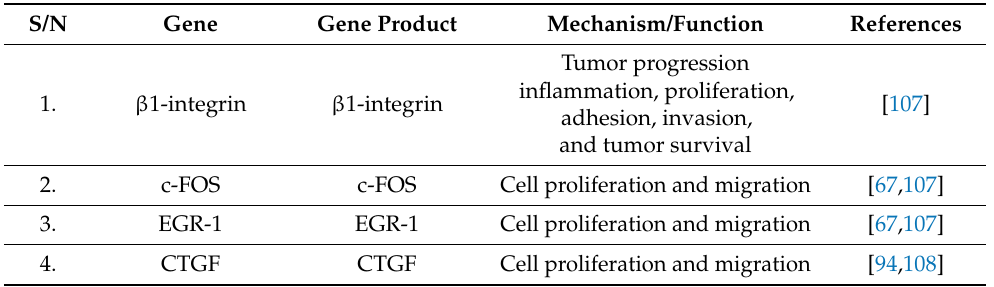
Table 2. GPER genes implicated in the progression of breast cancer malignancies. S/N Gene Gene Product